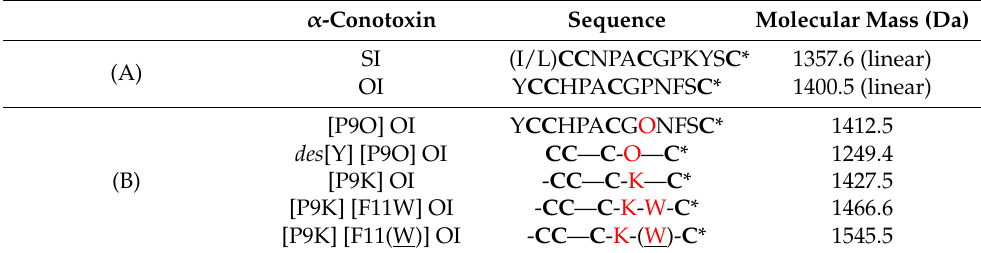
Table 1. Peptide sequence comparison of analogs and native α -conotoxins discovered within the milked venom of Conus obscurus. (A) αα sequences were generated and confirmed via MALDI-TOF sequencing from the pooled TCEP reduced MV of C. obscurus. Molecular masses are calculated in reduced form. α -SI N-terminal contains the isobaric mass corresponding to either isoleucine or leucine. (B) Peptide analogs derived from α -OI. Molecular masses are calculated in the oxidized form (disulfide bonds present). The αα highlighted in red represent single and double mutations introduced into α -OI. α -Conotoxin Sequence Molecular Mass